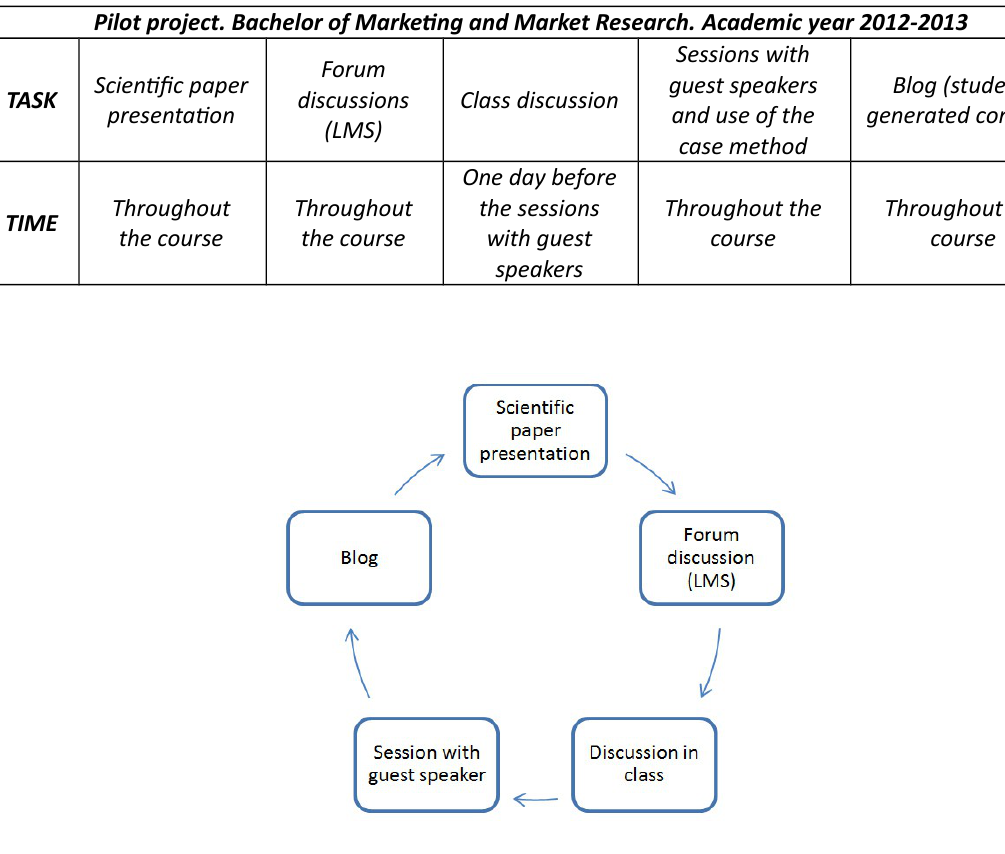
Figure 1. Steps followed throughout the